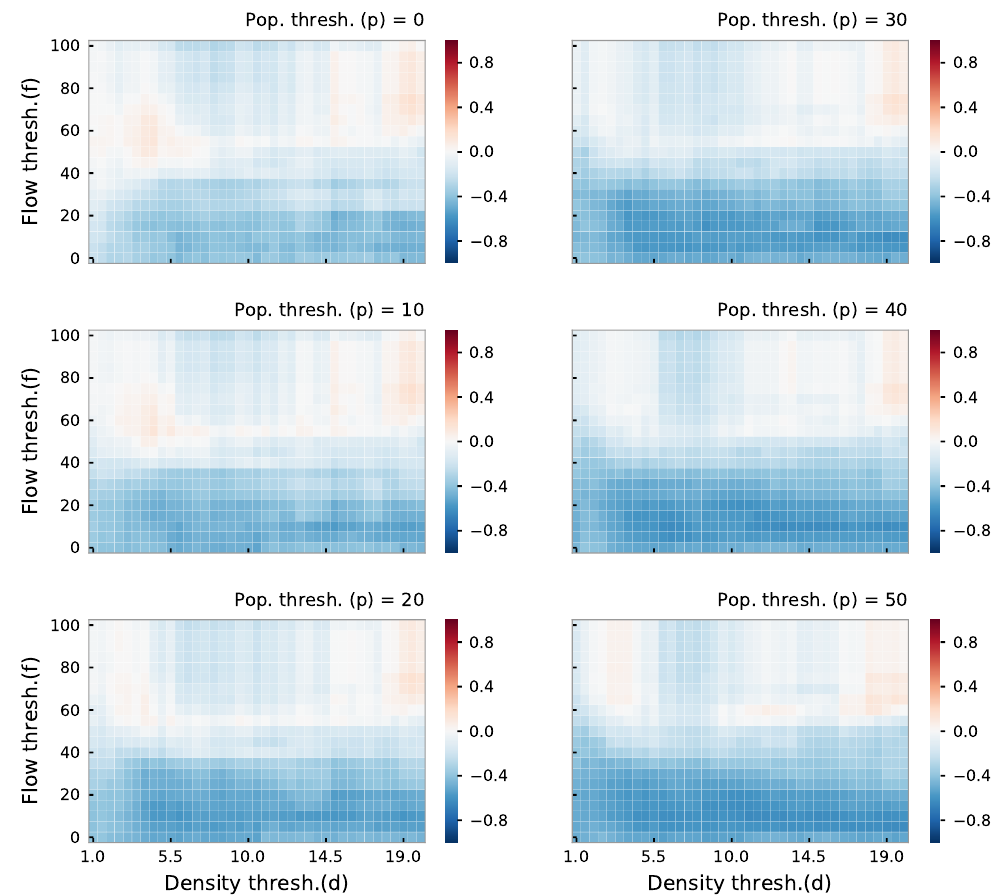
Figure 8. Heatmap of the Pearsons’s R for the relation between the entropy of contacts and the segregation index of wages for all city definitions represented in their according parameter-space. Each square on the heatmaps represents one of the 4914 city definitions projected in the space of definition criteria (x = density threshold, y = flow threshold, z = population threshold). It is coloured according to the value of the correlation index between the variable for the given definition. Density thresholds ( d ) are for the city centers and in thousands inhabitants/hectare, flow thresholds (f) are in percentage of population commuting to the city center, and population thresholds (p) are in thousands inhabitants in the wider city. As can be deduced, the top row plots have a population threshold ( p ) of